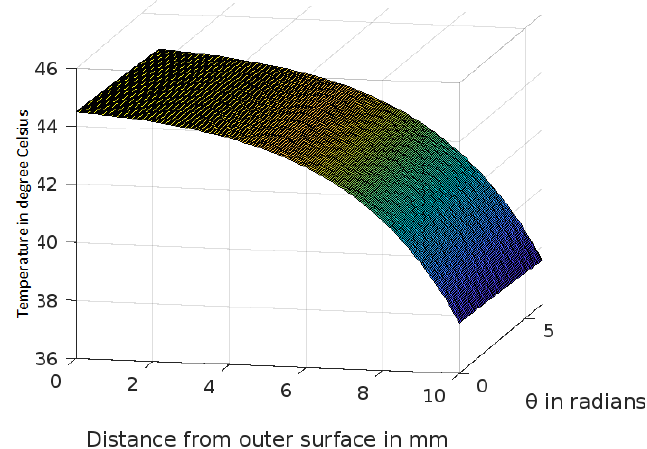
Figure 8. Variation of temperature profiles in human skin with an external temperature at the skin surface of 45 ◦